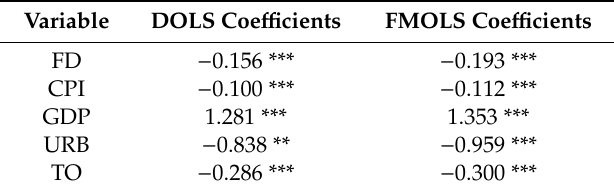
Table 5. Estimation of long-term coe ffi